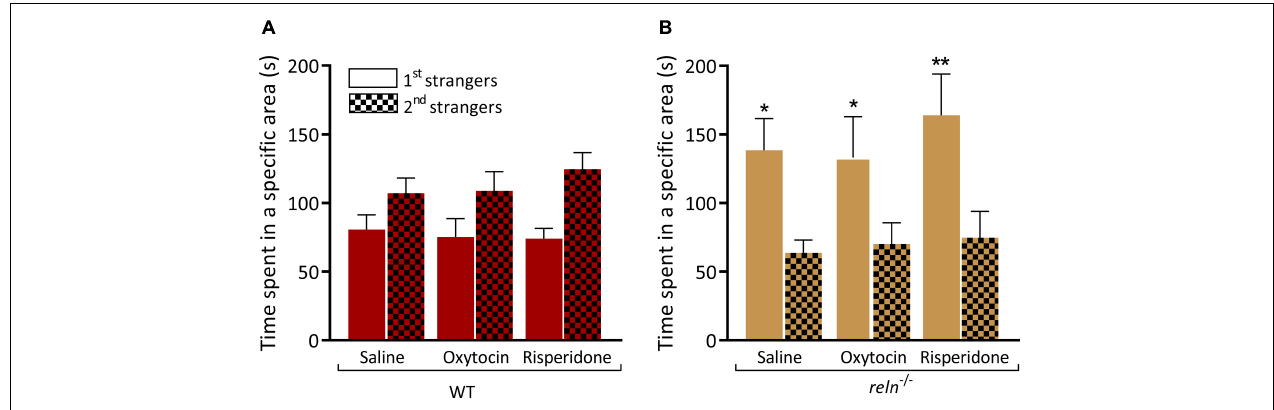
FIGURE 8 | Oxytocin and risperidone do not rescue preference for social novelty. (A) WT treated with saline ( p = 0.57), oxytocin ( p = 0.53), and risperidone ( p = 0.14) spend equal time near the two groups of unfamiliar fish. (B) Neither oxytocin ( p = 0.048) nor risperidone ( p = 0.0023) treatment rescues the impaired preference for social novelty of reln − / − zebrafish (saline control, p = 0.014). Three-way ANOVA followed by Sidak’s post hoc for oxytocin, genotype factor: F (1,64) = 0.3928, p = 0.53, stranger factor: F (1,64) = 2.133, p = 0.15, treatment factor: F (1,64) = 0.0143, p = 0.90, interaction genotype × stranger: F (1,64) = 17.44, p < 0.0001, interaction genotype × treatment: F (1,64) = 0.0282, p = 0.87, interaction stranger × treatment: F (1,64) = 0.0707, p = 0.79, interaction stranger × genotype × treatment: F (1,64) = 0.04759, p = 0.83. Three-way ANOVA followed by Sidak’s post hoc for risperidone, genotype factor: F (1,64) = 1.073, p = 0.30, stranger factor: F (1,64) = 2.573, p = 0.11, treatment factor: F (1,64) = 0.8058, p = 0.37, interaction genotype × stranger: F (1,64) = 25.65, p < 0.0001, interaction genotype × treatment: F (1,64) = 0.3363, p = 0.56, interaction stranger × treatment: F (1,64) = 0.01244, p = 0.91, interaction stranger × genotype × treatment: F (1,64) = 0.4869, p = 0.49. n = 9 WT and n = 9 reln − / − . ∗ p < 0.05, ∗∗ p < 0.01. Mean ±